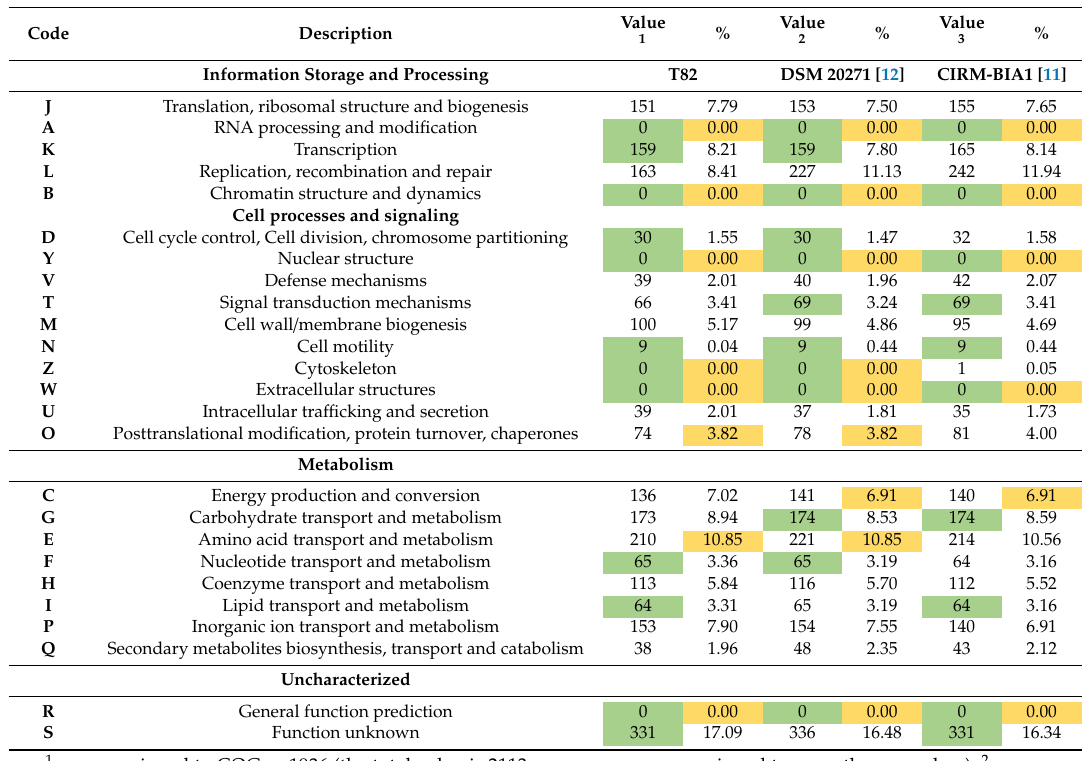
Table 4. Number of genes associated with general Clusters of Orthologous Groups of Proteins (COGs) functional